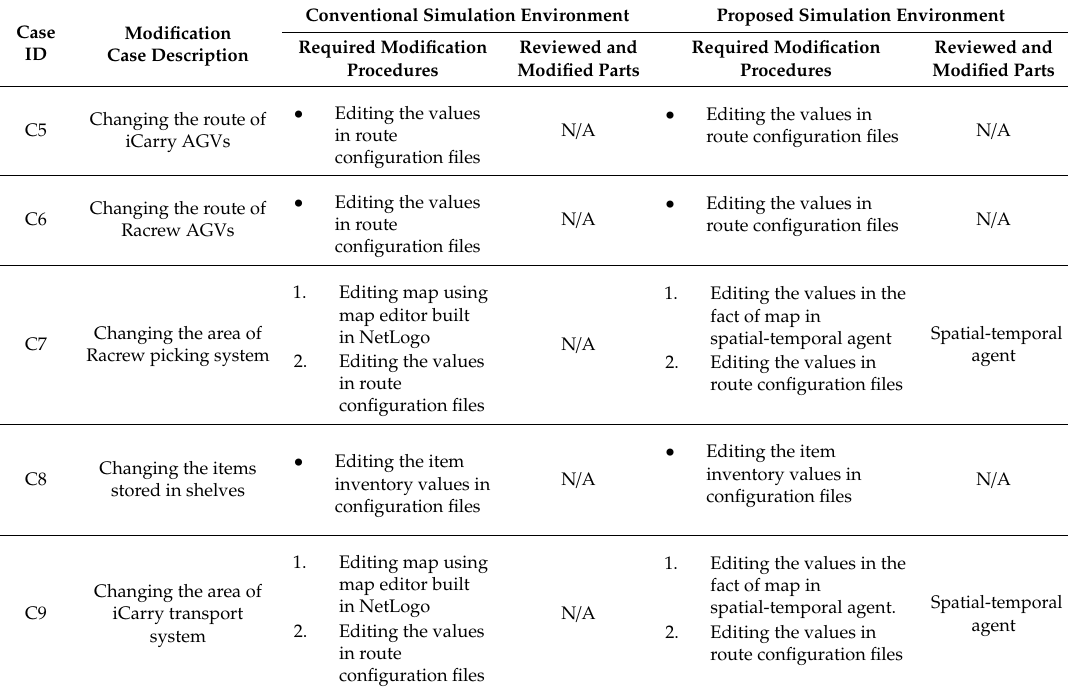
Table A1. Modification cost evaluations on modification cases of agent